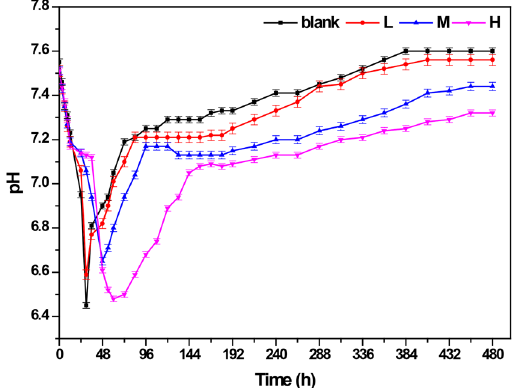
Figure 2. pH variation at different concentrations of NaCl.